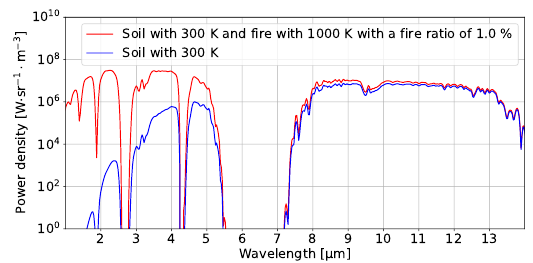
Figure 4. Simulation of the power density after the atmosphere at varying wavelength emitted by soil with and without